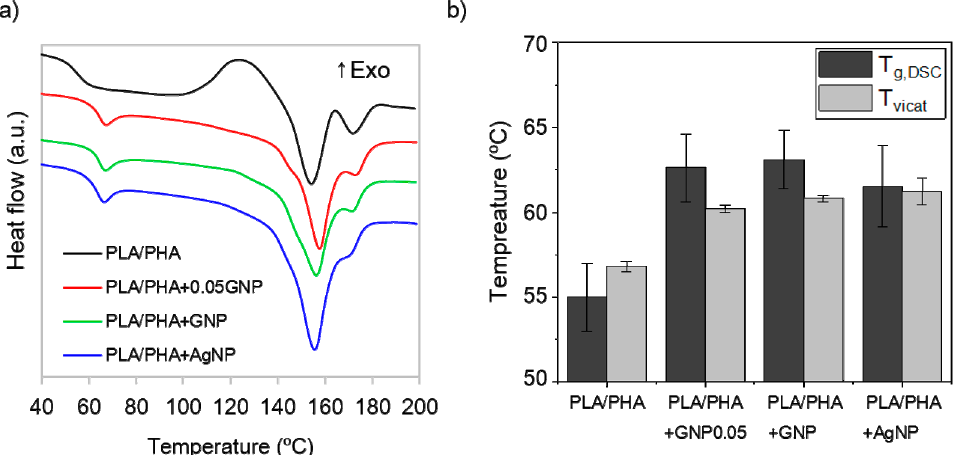
Figure 6. ( a ) DSC thermograms of PLA/PHA (black); PLA/PHA+0.05GNP (red); PLA/PHA+GNP (green), and PLA/PHA+AgNP (blue); ( b ) comparison between extracted T g from DSC sweeps (dark grey bars) and softening temperature from Vicat assay (light grey bars). (DSC: Differential Scanning Calorimetry).